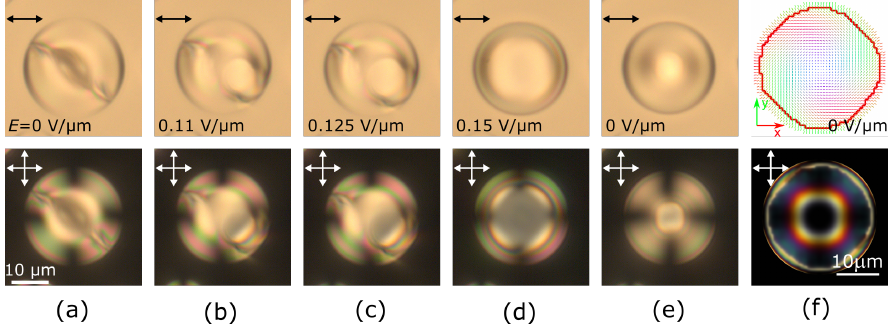
Figure 1. Experimental polarized optical microscopy images ( a – e ) of the cholesteric droplet at N 0 = 3.9 taken with one polarizer (top row) and in the crossed polarizers (bottom row). Initial state with the circular defect perpendicular to the film plane ( a ), under an electric field E equal to 0.11 V/ µ m ( b ), 0.125 V/ µ m ( c ), 0.15 V/ µ m ( d ), and after switching off the voltage ( e ). Intrinsic helix pitch is p 0 = 14 µ m, the scale remains the same on the images ( a – e ). Calculated director distribution ( f , top row) and the corresponding simulated polarized optical microscopy image ( f , bottom row). Hereinafter, double arrows indicate the direction of the polarizers, and the director n is colored in correspondence with the direction (red along the x -axis, green along the y -axis, blue along the z -axis), the thick red line indicates the circular defect near the